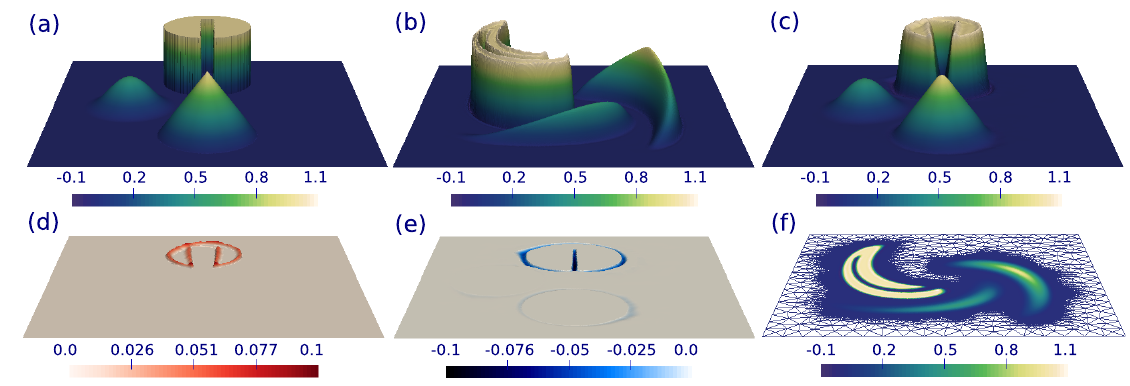
Figure 7. Results of 2-D swirling flow three body test for refinement time step 0 . 01 π s. (a) Initial condition, (b) solution at t total / 2 and (c) solution at t total . (d) Overshoots (values greater than maximum initial value, as deviation from max (c initial ) = 1 . 0), (e) undershoots (values smaller than minimum initial value, as deviation from min (c initial ) = 0 . 0) at t total and (f) solution at t total / 2 on the underlying mesh, shown in plan view. Colour scales show concentration